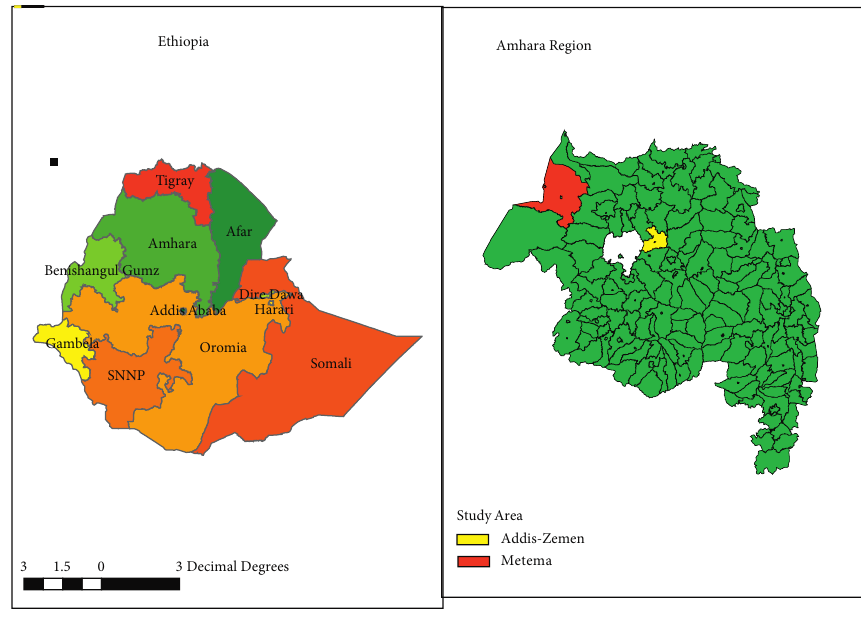
Figure 1: Map depicting the study areas. Table 1: Sociodemographic characteristics and rK39 results of VL suspected cases at two health facilities in Amhara Region northwest Ethiopia from Oct 2017 to May